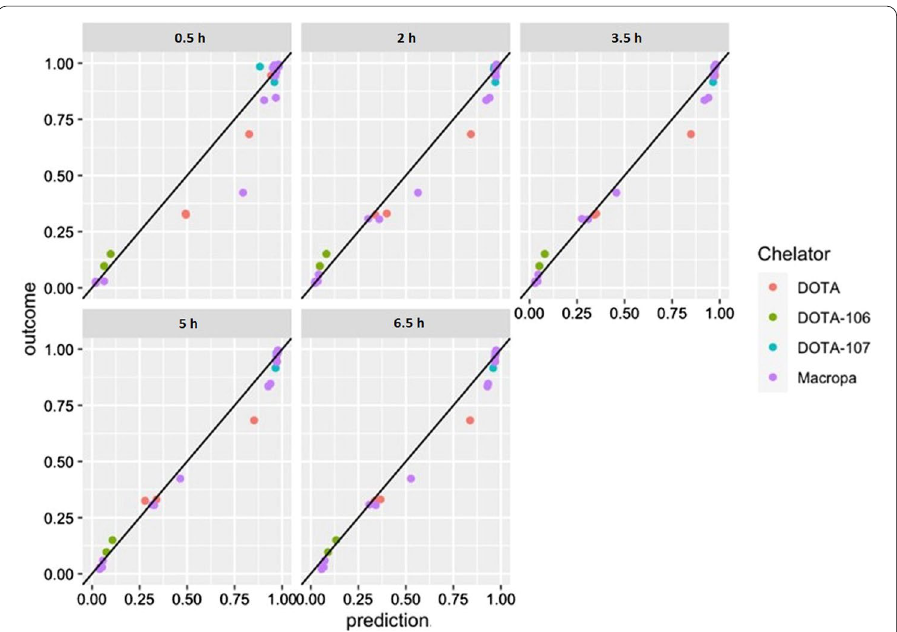
Fig. 5 Predictive accuracy of QC measurements taken at 0.5 h, 2 h, 3.5 h, 5 h, or 6.5 h after running the radioTLC plate. Each plotted point represents the outcome of a reaction involving a compound conjugated to DOTA (red) or a DOTA‑derivative (green, cyan) or a compound conjugated to macropa (purple). X‑axis: Predicted radiochemical yield. Y‑axis: True radiochemical yield, defined as the radiochemical yield when measured at 26 h after running the